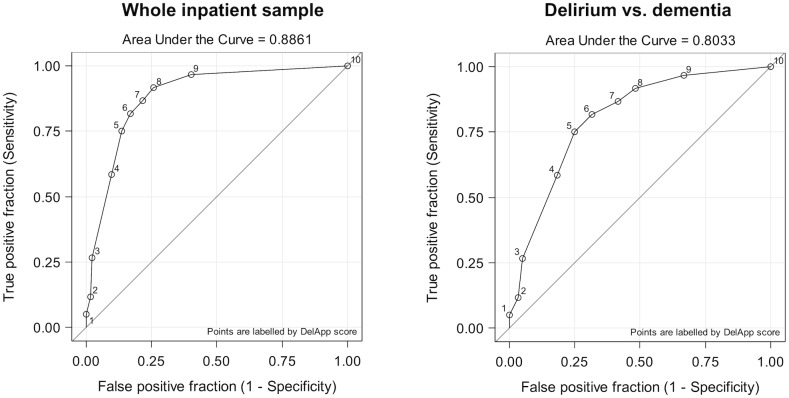
Receiver Operating Characteristic curves for DelApp for detecting DSM-5 delirium in the whole sample (i.e. delirium, dementia and cognitively normal groups; left panel) and for discriminating between delirium (with or without dementia) and dementia groups (right panel).